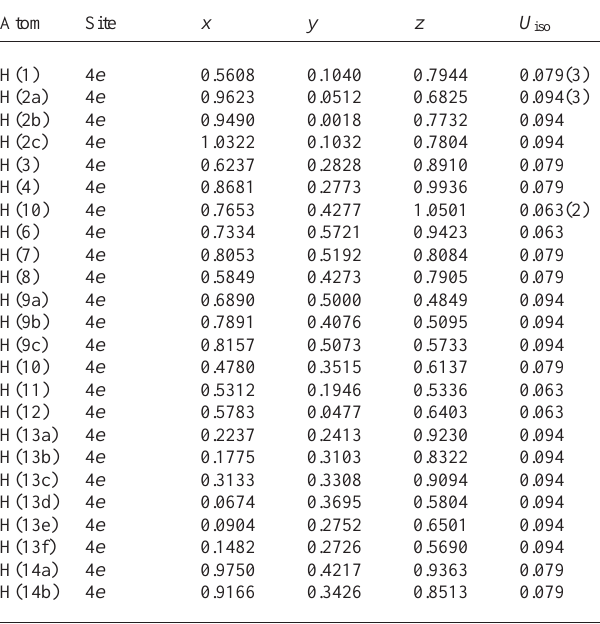
Table 2. Atomic coordinates and displacement parameters (in Å 2 )